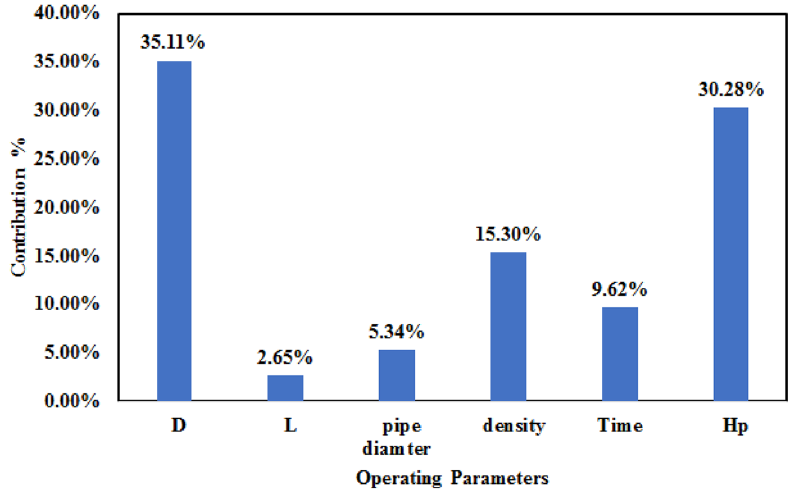
Figure 10. Contribution percentage of each parameter on the variation of storage